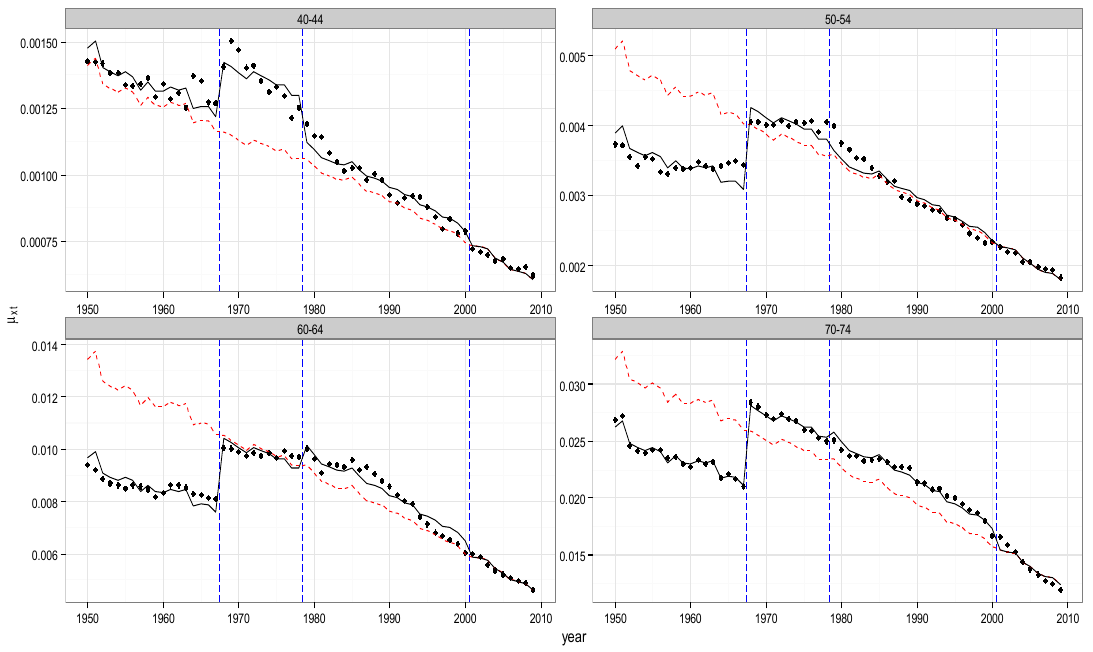
Figure 5. Adjusted mortality index ‐ Cancer and Circulatory System, UK Female population, age groups 40–44, 50–54, 60–64, 70–74.